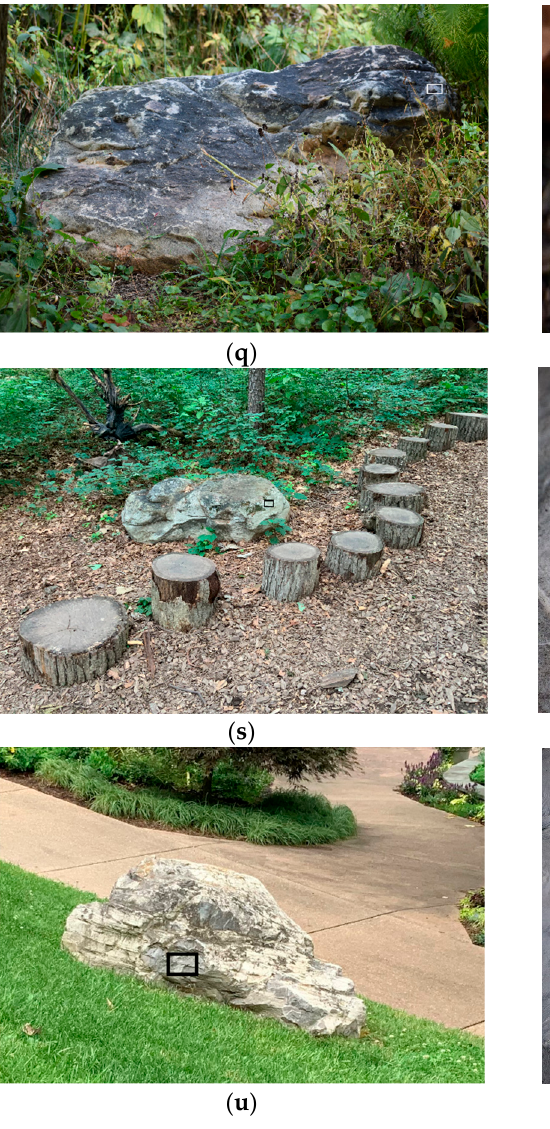
Figure 1. Samples collected at the Edith J. Carrier Arboretum representing the rock types described in this study. Penny for scale. ( a ) Sample 1 (shale); ( b ) sample 1 (detail); ( c ) sample 2 (shale); ( d ) sample 2 (detail); ( e ) sample 3 (quartzite); ( f ) sample 3 (detail); ( g ) sample 4 (quartzite); ( h ) sample 4 (detail); ( i ) sample 5 (dolostone); ( j ) sample 5 (detail); ( k ) sample 6 (quartzite); ( l ) sample 6 (detail); ( m ) sample 7 (quartzite); ( n ) sample 7 (detail); ( o ) sample 8 (dolomitic limestone); ( p ) sample 8 (detail); ( q ) sample 9 (dolostone); ( r ) sample 9 (detail); ( s ) sample 10 (quartzite); ( t ) sample 10 (detail); ( u ) sample 11 (dolostone); ( v ) sample 11 (detail).